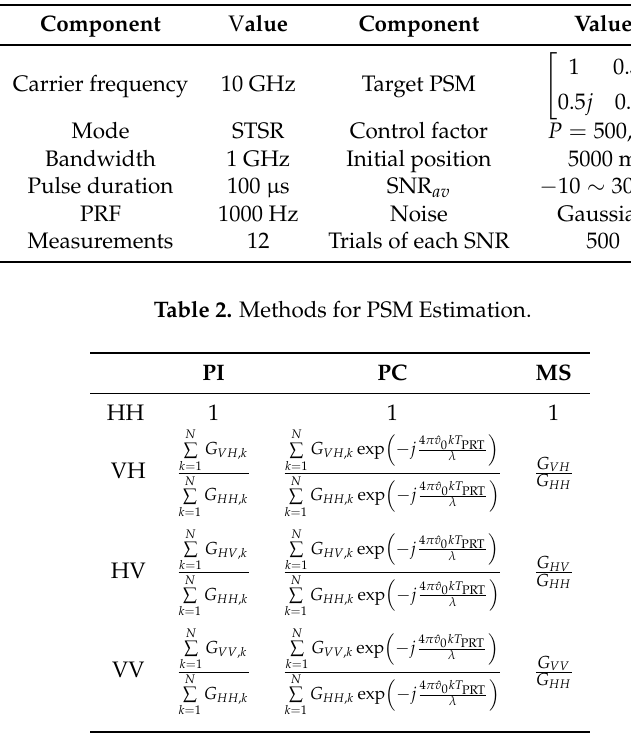
Table 1. Parameters for numerical experiments.